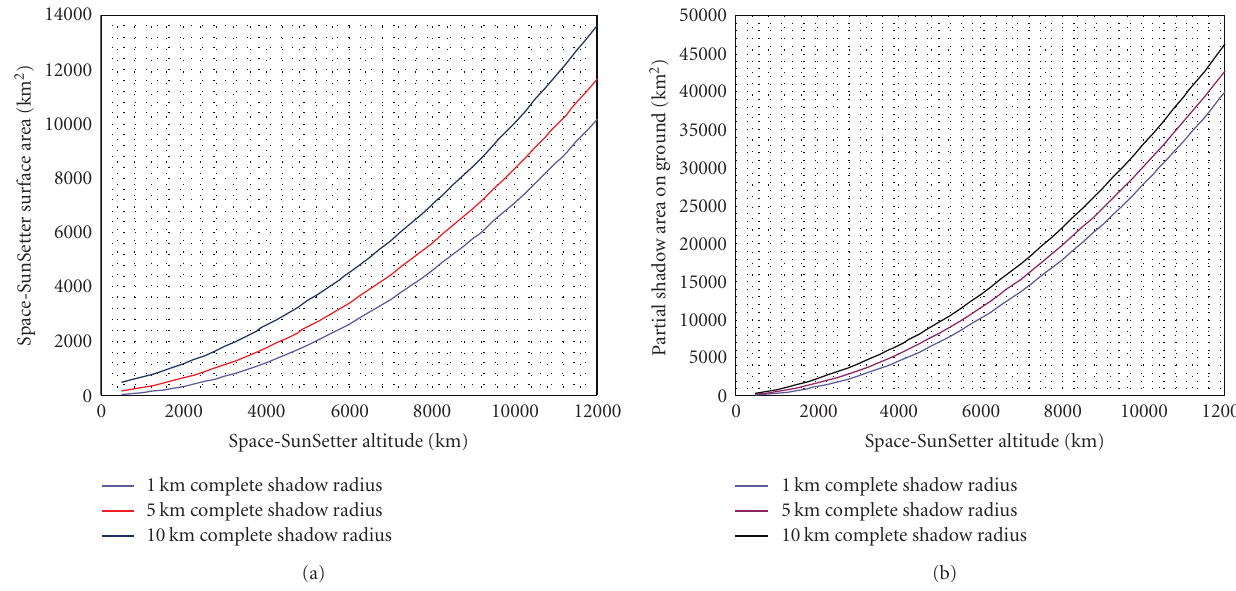
Figure 3: (a) Space SunSetter area, and its (b) partial shadow area on the Earth’s surface.